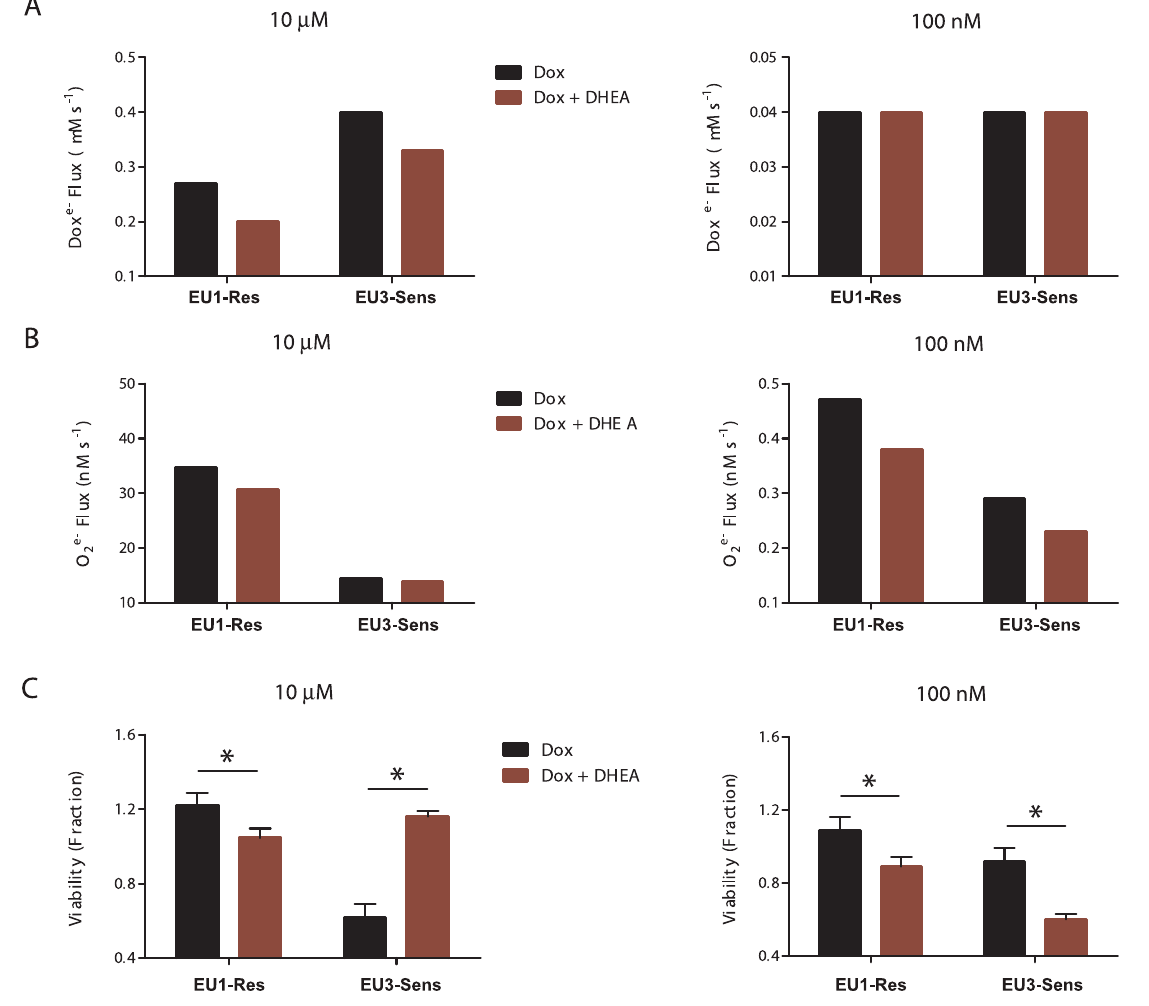
Figure 5. NADPH supply alters doxorubicin sensitivity in ALL cells in a concentration- and cell-dependent manner. (A) in silico model predictions of NADPH-dependent semiquinone doxorubicin flux in ALL cells, with and without DHEA intervention, at the 10 m M and 100 nM doxorubicin concentration conditions. (B) in silico model predictions of NADPH-dependent superoxide flux in ALL cells, with and without DHEA intervention, at the 10 m M and 100 nM doxorubicin concentration conditions. (C) Experimentally determined (WST1 assay) cell viability for ALL cells after 3 hr doxorubicin treatment, at the 10 m M and 100 nM doxorubicin concentration conditions. (DHEA=10 m M, 24 hrs; *p , 0.05).